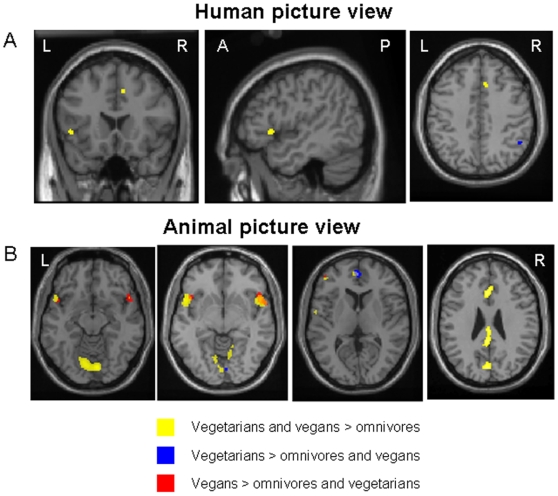
Results of the between-group comparisons of emotional (human and animal) negative valence picture views.Results are superimposed on a high resolution T1-weighted image in the standard MNI space, at a threshold of p<0.05 corrected for multiple comparisons. Areas activated during human picture view in vegetarians and vegans vs. omnivores are shown in yellow. Activations specific for vegetarians are shown in blue. Activations specific for vegans are shown in red. A: human picture view; B: animal picture view. Images are in neurological convention.